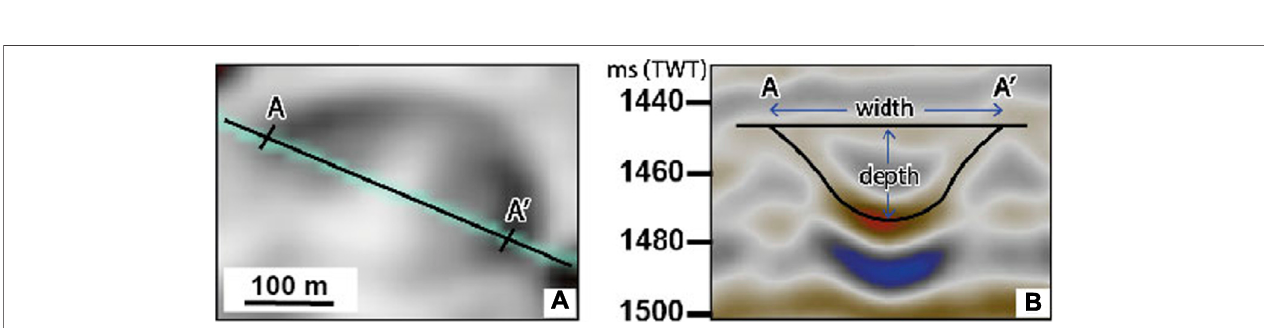
FIGURE 8 | Characteristics of a paleo-pockmark showing the (A) top view and (B) side view. The paleo-pockmark width and depth are measured in seismic section. Width is measured from the longest axis of pockmark between pockmark edges (A-A ′ ), while depth is measured in a vertical direction from pockmark crater to pockmark